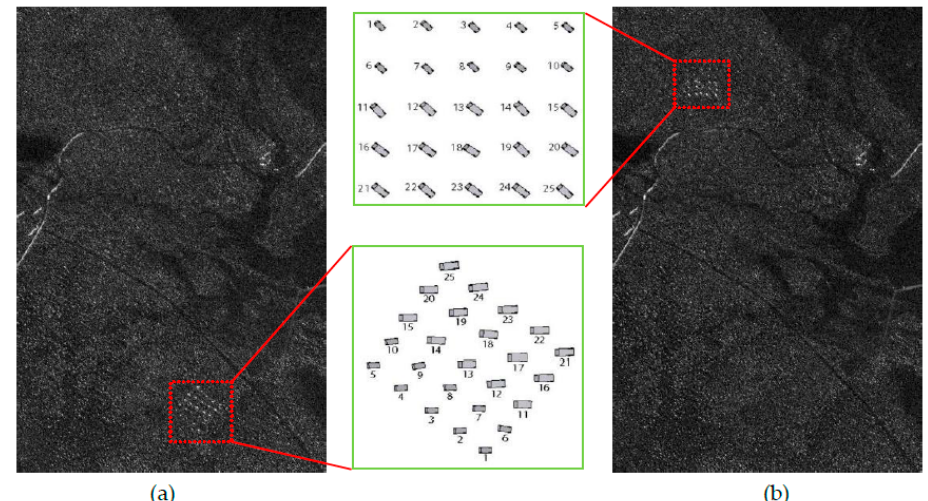
Figure 3. VHF-band SAR image pair (vehicles are located in red boxes) used to the second experiment: ( a ) reference image of pass 3 in mission 5; ( b ) test image of pass 3 in mission 3. Note that the sketch of target deployment is also given in this figure.